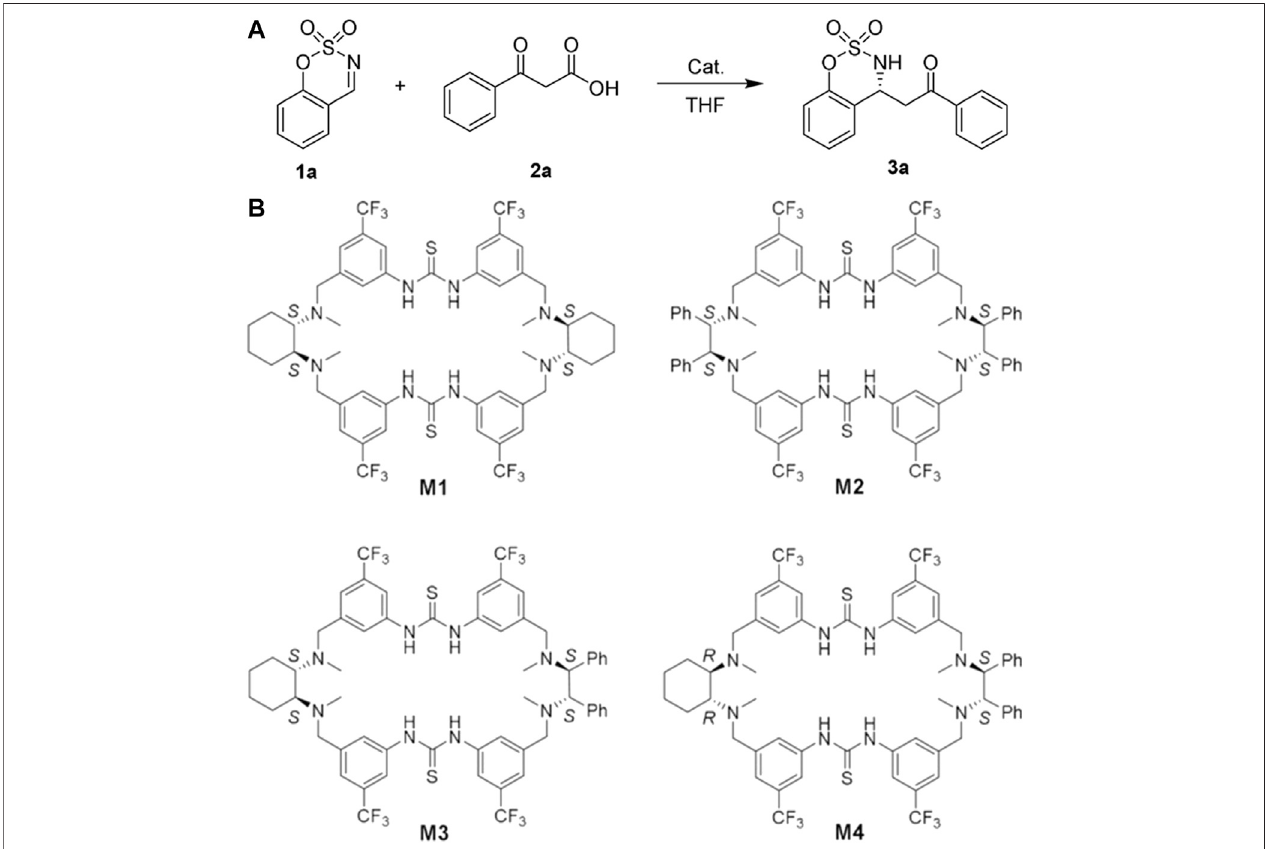
FIGURE 2 | (A) The decarboxylative Mannich reaction ‘ promoted by chiral macrocycle catalysts for asymmetric catalysis. (B) The effects of different macrocyclic conformations and chiral microenvironments on catalytic ef fi ciency and enantioselectivity were studied by evaluating the catalytic behaviors of macrocycle M1-M4. M4 achieved a 99% yield and 94:6 enantiomeric ratio (er) under optimal conditions, while M1-M3 gave a relatively lower. A and B Reproduced from Guo et al. (2020) with permission. Copyright 2020 Wiley-VCH Verlag GmbH & Co. KGaA, Weinheim.